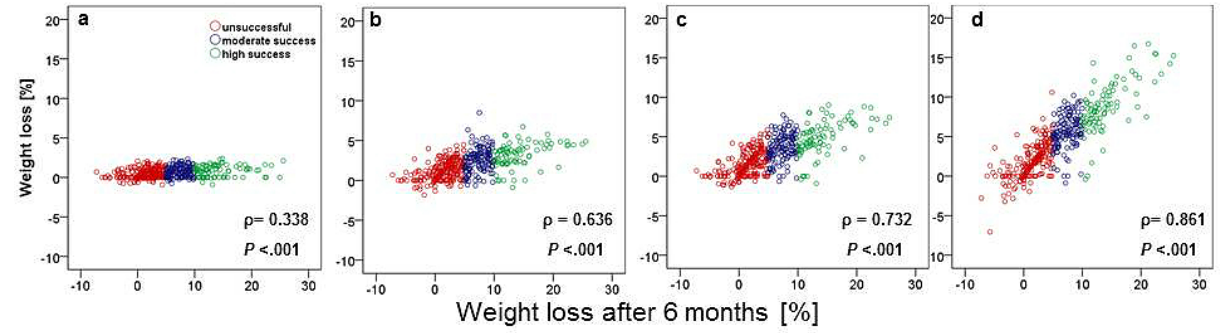
Figure 4. Correlation (Spearman rho, ρ ) between early weight loss and weight loss outcome after 6 months during weeks 1-2 (a), weeks 3-4 (b), weeks 5-6 (c), and after 3 months (d) for the unsuccessful (<5% weight loss), moderate success (5%-9.9% weight loss), and high success ( ≥ 10% weight loss) groups using